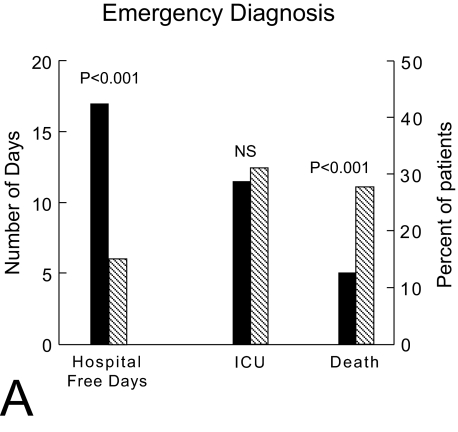
Effects of an appropriate (black bars) or inappropriate (white bars) initial diagnosis in the emergency department on prognosis (used with permission from Ray et al. 2006a).